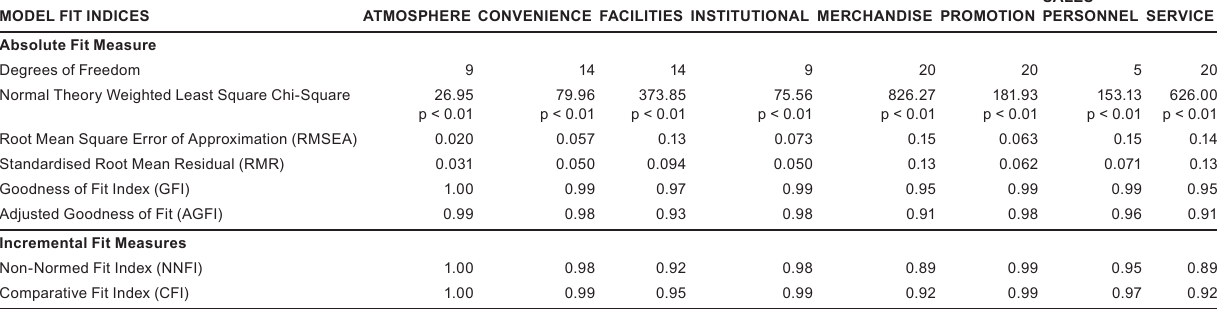
TABLE 3 Model fit indices of CFA on individual dimensions – Mall intercept